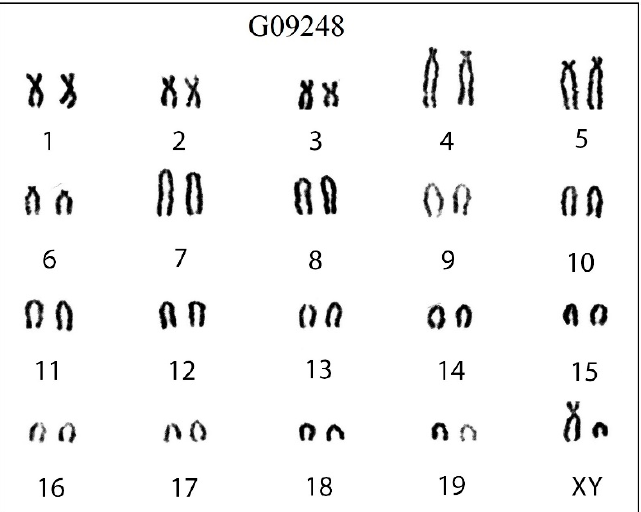
Figure 3. The karyotype of C. dongyangjiangensis in mainland China. The diploid chromosome number (2 n) is 40 and fundamental arm number (FN) is 54, with three pairs of metacentric or submetacentric (m/sm), three pairs of subtelocentric (st), and 13 pairs of acrocentric autosomes (t), a submetacentric X chromosome (X), and an acrocentric Y chromosome (Y). The order of the chromosomes is m/sm, st, t, X, Y and then from large to small chromosomes. The numbers 1–19 represent the number of chromosome pairs, and G09248 is the label of the